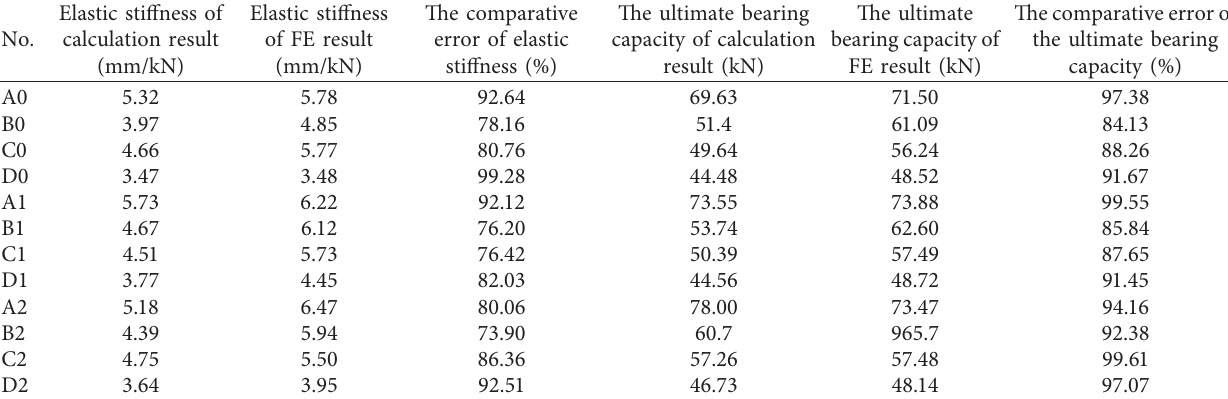
Table 6: Comparative error analysis of calculation and finite element skeleton curves.